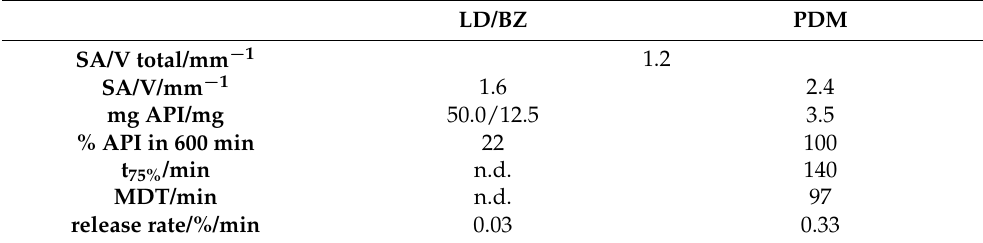
Figure 6. ( Left ): release profile of PP1; modified basket apparatus, 1000 mL 0.1 N HCl, 50 rpm, 37.0 ± 0.5 °C, x ± s; n = 3. ( Right ): Image of PP1: red: PDM-PVA, blue: LD/BZ-EVA. Table 7. Structure and release properties of PP1.